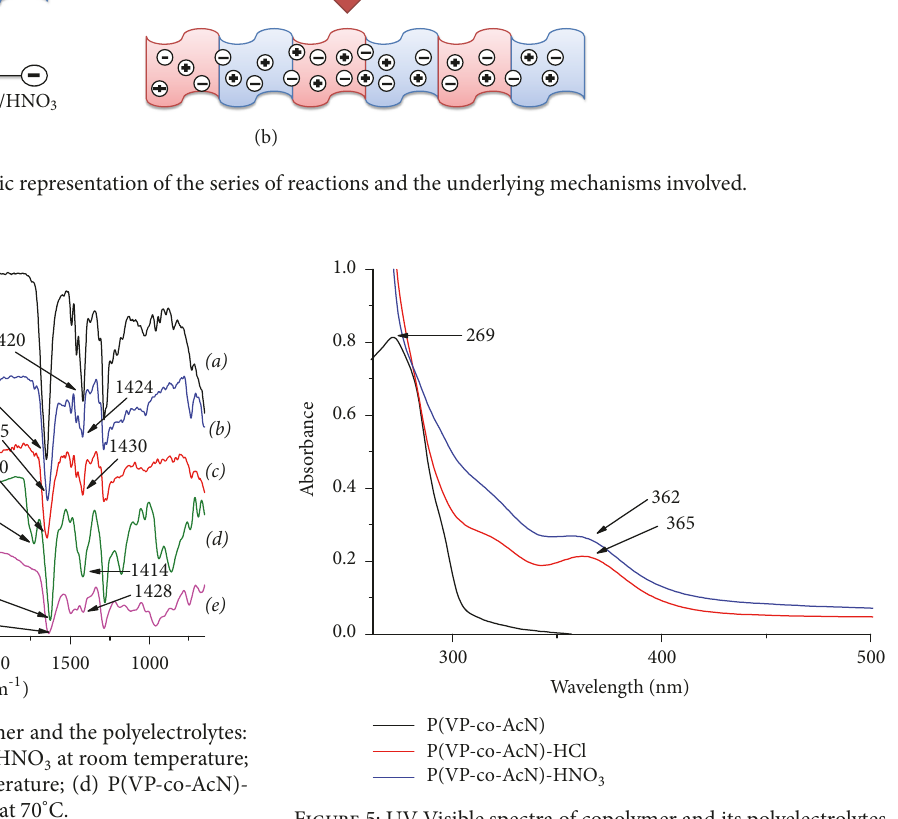
Figure 5: UV-Visible spectra of copolymer and its